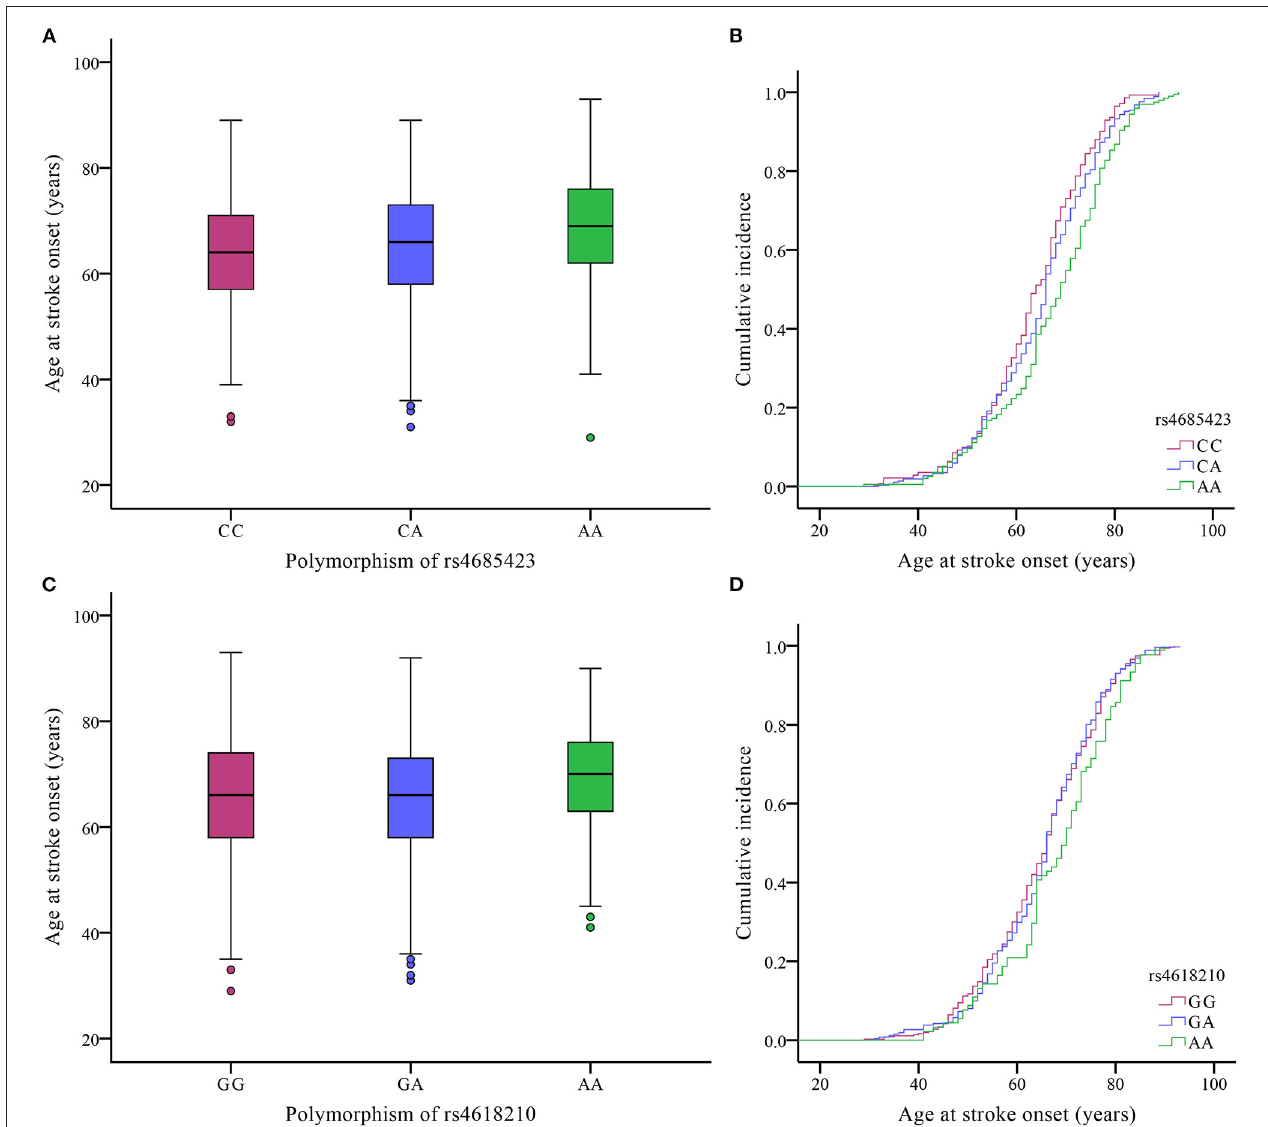
FIGURE 1 | Effects of the polymorphisms of rs4685423 and rs4618210 on the age of ischaemic stroke onset in the cases. (A) Box plot of age at onset among ischaemic stroke patients with the CC genotype, CA genotype and AA genotype in rs4685423 ( P = 0.003); (B) Cumulative incidence curve of ischaemic stroke patients with the polymorphisms of rs4685423 (log-rank P < 0.001); (C) Box plot of age at onset among ischaemic stroke patients with the GG genotype, GA genotype and AA genotype in rs4618210 ( P = 0.079); (D) Cumulative incidence curve of ischaemic stroke patients with the polymorphisms of rs4618210 (log-rank P =